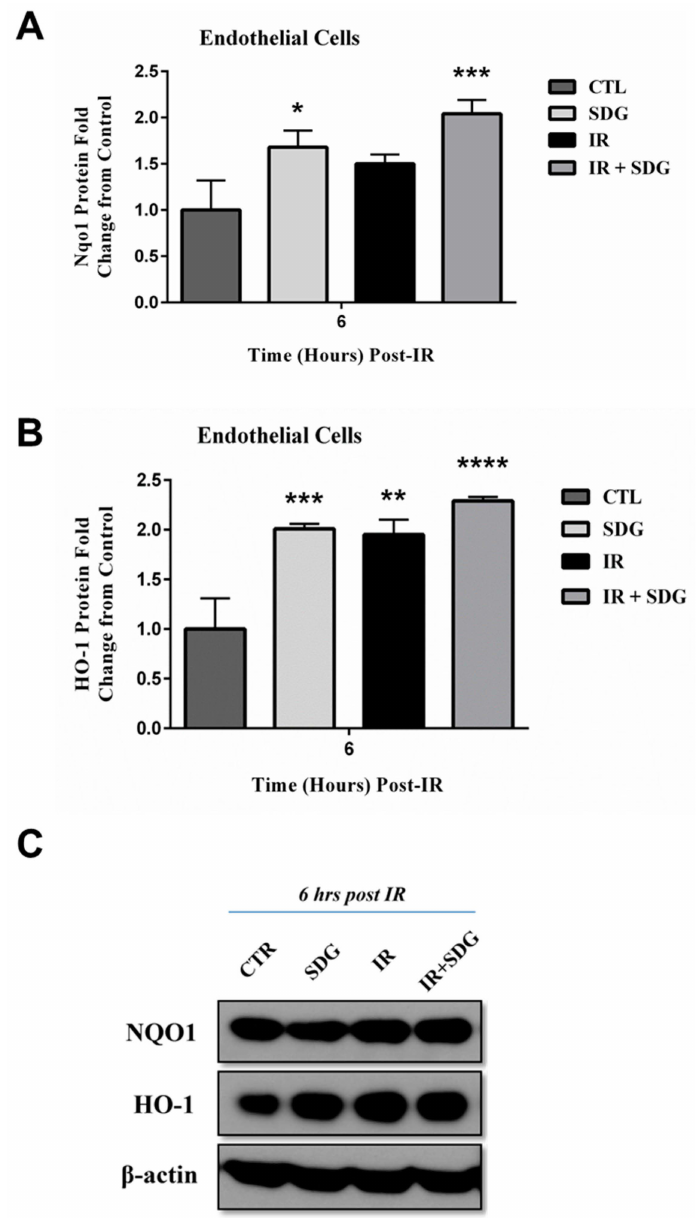
Figure 5. Western blot analysis of SDG-induced changes in levels of antioxidant/cytoprotective enzymes HO-1 and NQO1, in endothelial cells, after radiation (2 Gy). Murine lung cells (epithelial cells) were treated with SDG (50 µ M) for six hours prior to exposure to γ -rays. Cells were harvested at six hours post-radiation. ( A ) Densitometric analysis of Nqo1 with normalization to β -actin; ( B ) Densitometric analysis of HO-1 with normalization to β -actin; ( C ) Representative Western blot images. Experiment was repeated three times and data are represented as mean fold change ˘